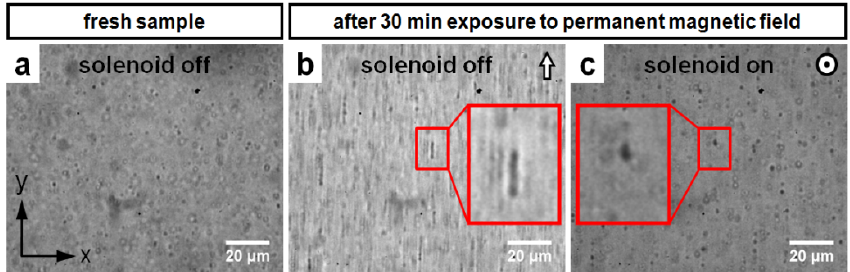
Figure 4. Magnetic particle behavior in the switchable magnetic field. ( a ) Bright-field transmission microscopy of magnetic nanoparticles dispersed in glycerin (0.5 mg/mL) in a freshly prepared sample; ( b ) after 30 min exposure to the permanent magnetic field with the solenoid switched off; and ( c ) shortly after with the solenoid switched on (30 V). The dominant direction of the magnetic field is indicated by the symbols in the upper left corner of the images ( ↑ —transverse, (cid:12) —longitudinal). The indicated coordinate system ( x , y ) is identical to Figure 2a. As illustrated by the magnified views (red rectangles), the particles in ( b ) have formed long chains that are aligned parallel to the image plane; when the solenoid is switched on in ( c ), these chains rotate and align perpendicular to the image plane. This rotation effect is reversible across many on/off cycles of the solenoid (see Scheme 1 and Video S1) (color online). Appl. Sci. 2017 , 7 , 444